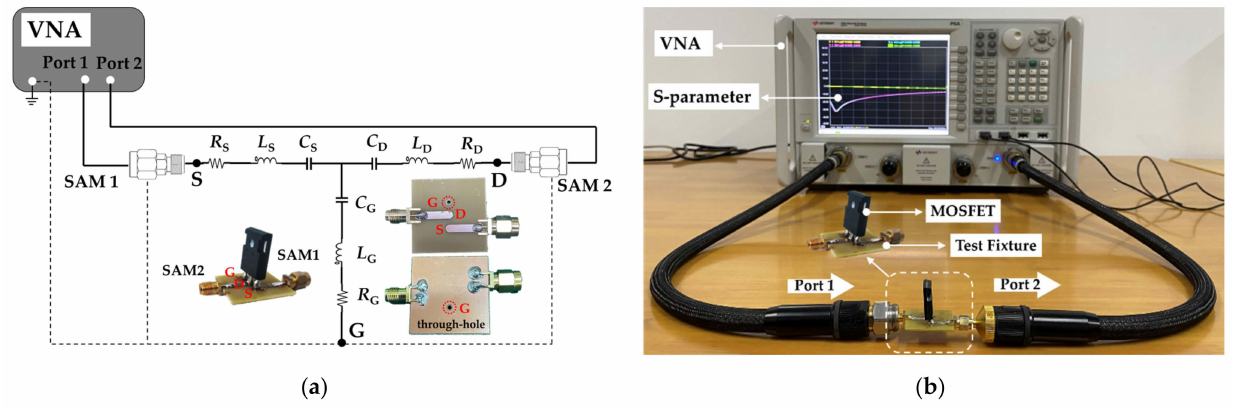
Figure 7. Two-port VNA measurement setup for MOSFET parasitic inductance extraction. ( a ) Schematic of proposed two-port network extraction approach. ( b ) VNA measurement setup including the PCB